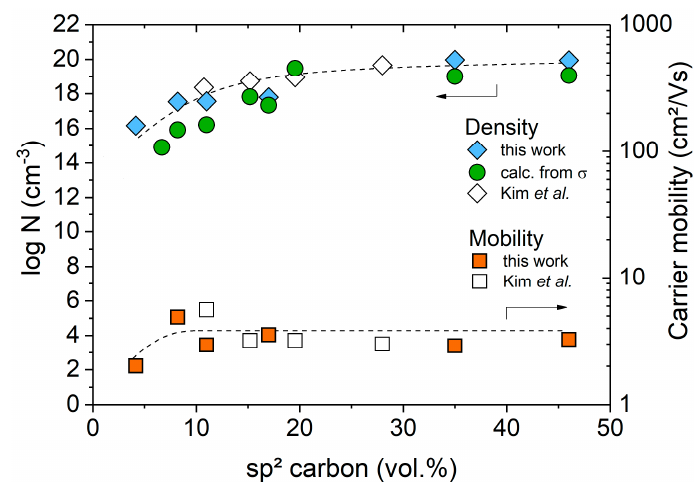
Figure 9. Charge carrier density (N) and mobility (µ) in SiOC/C materials prepared at T = 1600 °C; the empty symbols represent data from a case study published by Kim et al. [76].